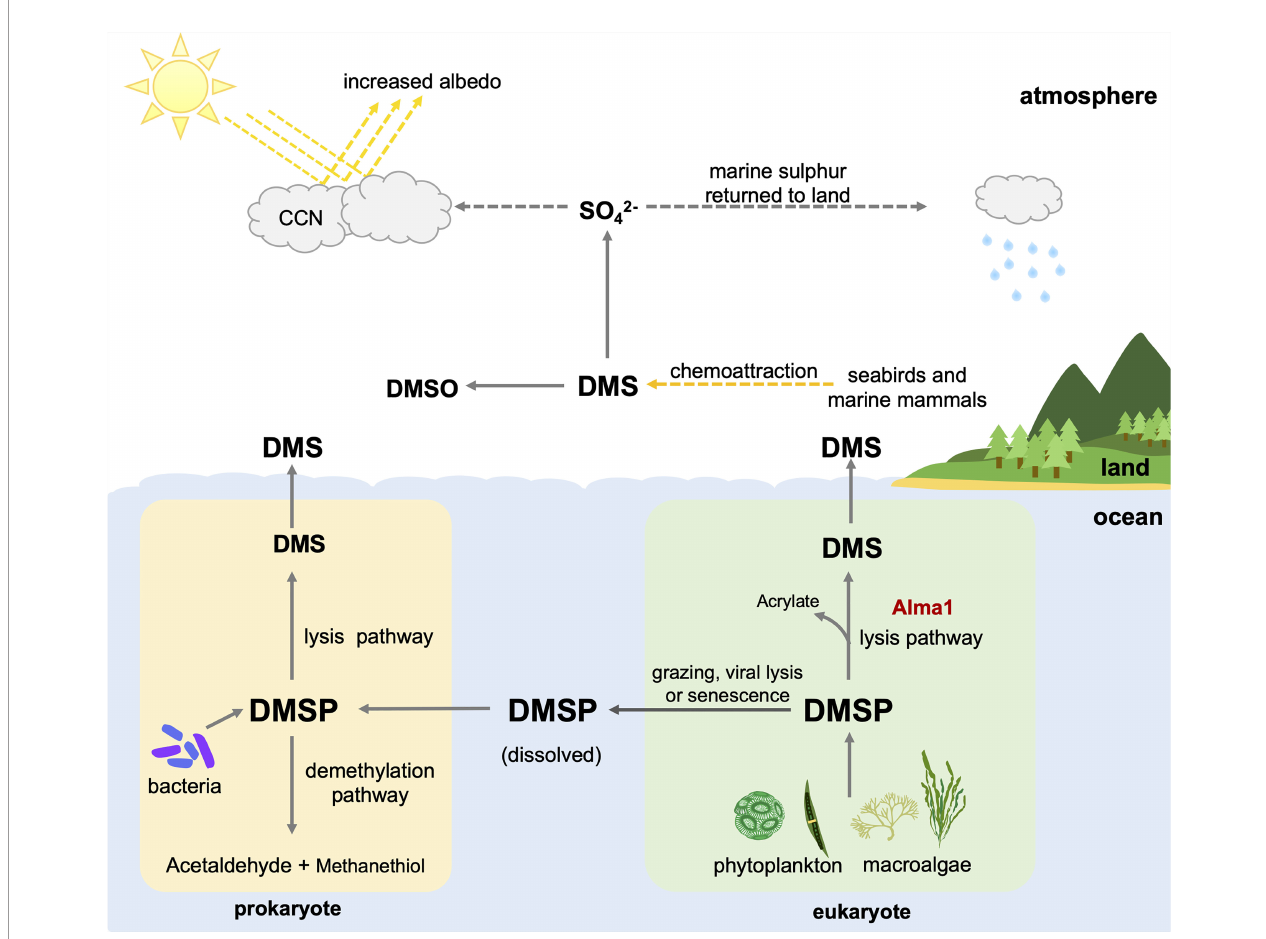
FIGURE 1 | Contributions of prokaryotes and eukaryotes to the biogeochemical cycle and possible functions of dimethylsulfoniopropionic acid (DMSP) and dimethyl sul fi de (DMS). CCN, Cloud condensation nuclei; DMSO, dimethyl